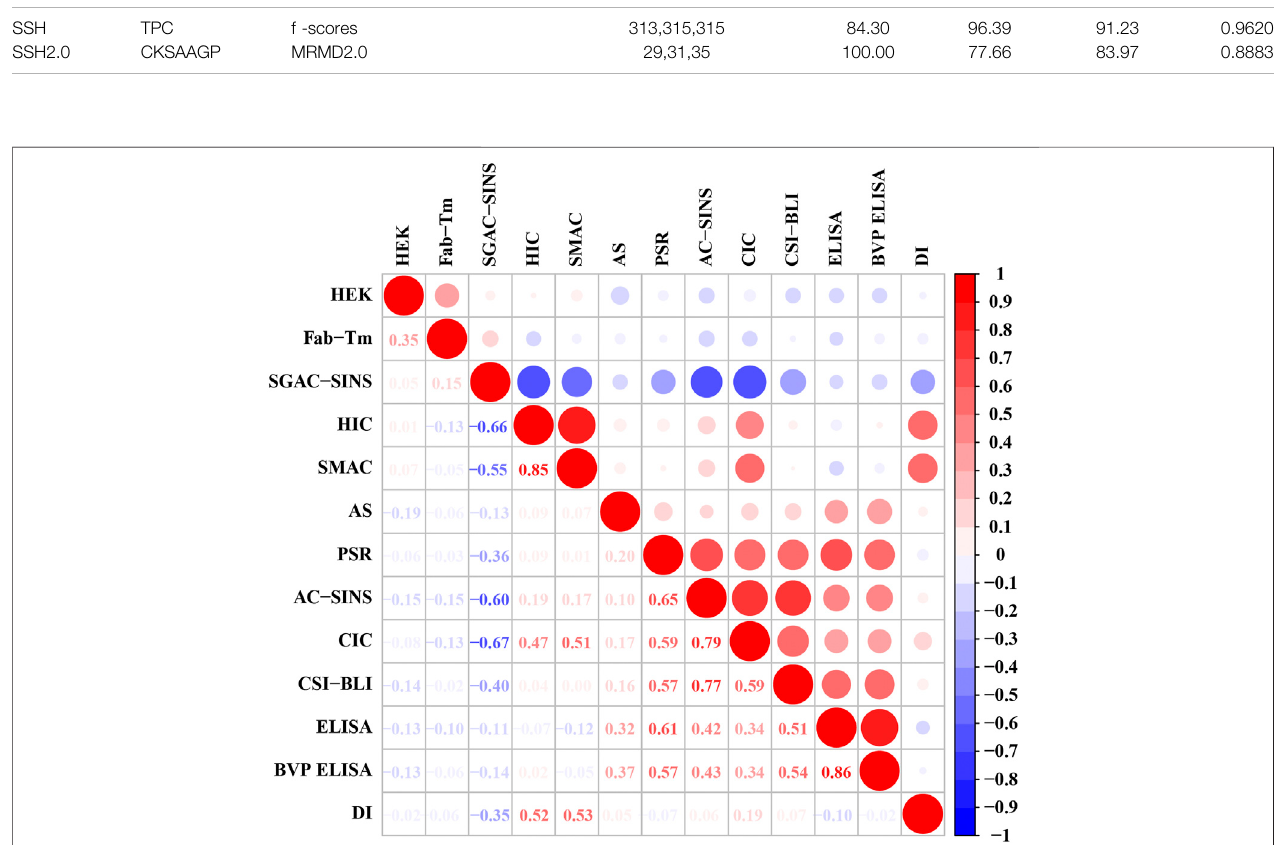
FIGURE 5 | Correlation coef fi cient matrix of DI and 12 experimental assays. The lower triangle shows the spearman correlation coef fi cients, and the upper triangle represents the corresponding correlation values. The radius of the circles is proportional to the magnitude of the correlation coef fi cient. Red represents a positive correlation, and blue represents a negative